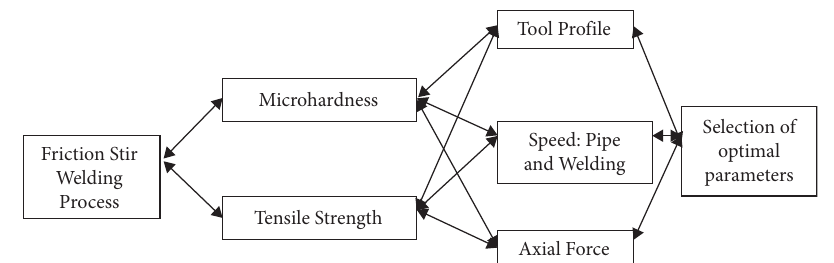
Figure 2: Friction stir welding operation